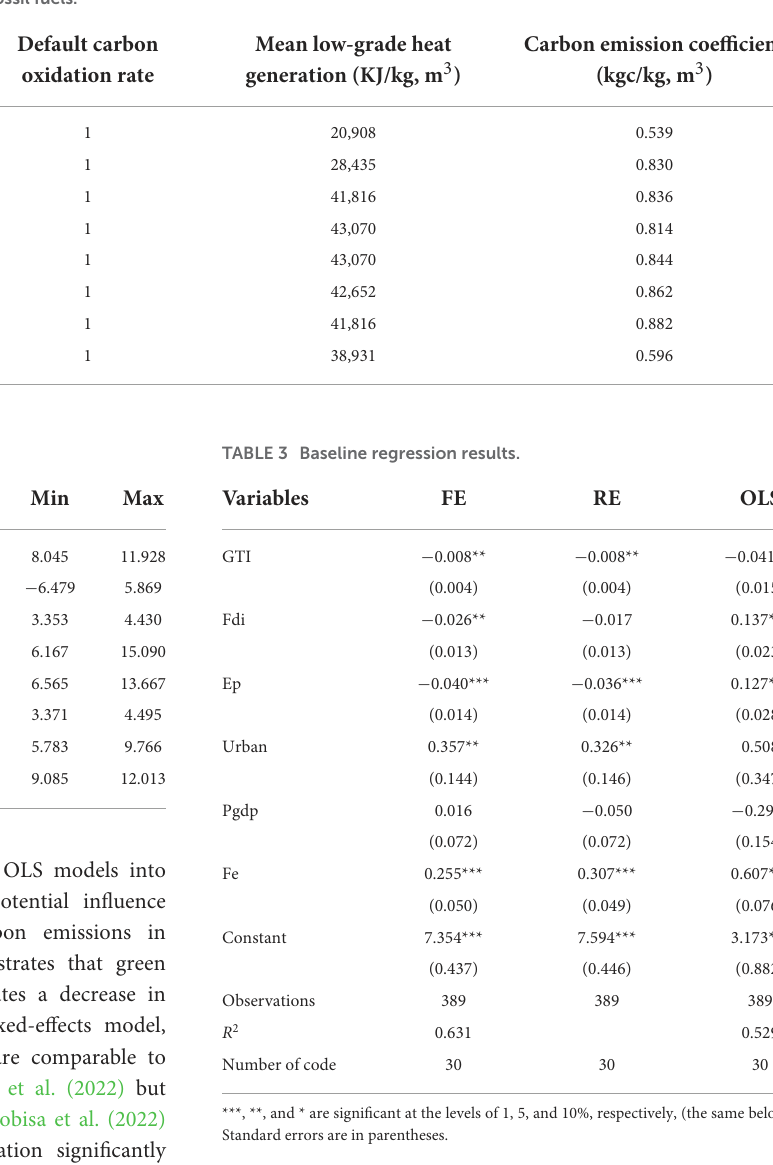
TABLE 1 Carbon emission coefficient of various fossil fuels.